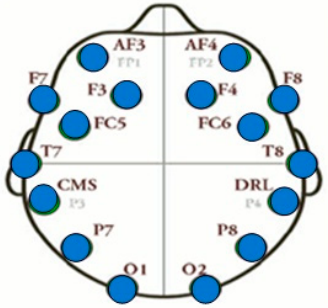
Figure 1. Electrode placement for Emotiv EPOC Figure. 1. Electrode placement for Emotiv EPOC headset.